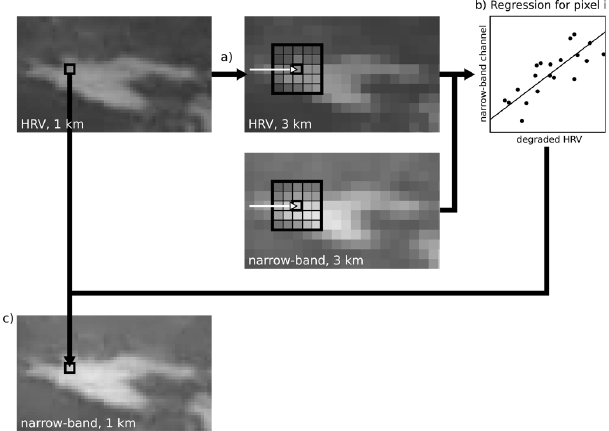
Fig. 4. The pan-sharpening algorithm adapted from Hill et al. (1999). After degradation of the HRV channel (a) a regression for each 3km pixel is calculated from the values of narrow-band pixels and degraded HRV pixels covered by a 5 × 5 pixels win- dow (b) . Each regression is used to calculate the values for 3 × 3 1km narrow-band pixels (corresponding to one 3km pixel) from 3 × 3 HRV pixels (c)